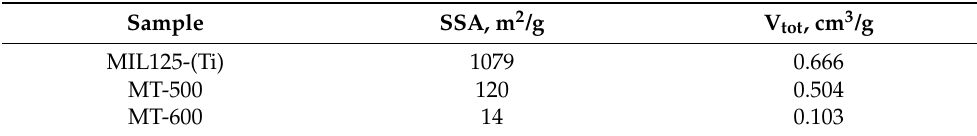
Figure 3. ( a ) N 2 adsorption isotherms of MIL125-(Ti), MT-500, and MT-600 at 77 K; ( b ) Pore size distributions of MIL125-(Ti), MT-500, and MT-600 estimated by applying the BJH model. Table 1. Materials textural properties.